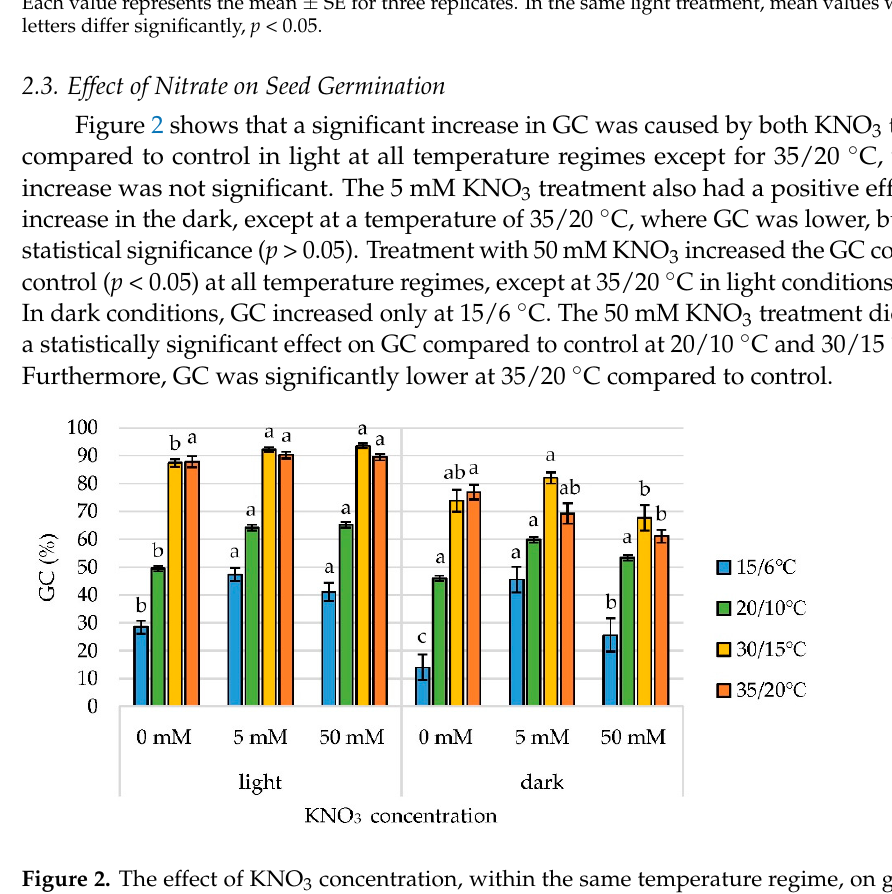
Each value represents the mean ± SE for three replicates. In the same light treatment, mean values with different letters differ significantly, p < 0.05.